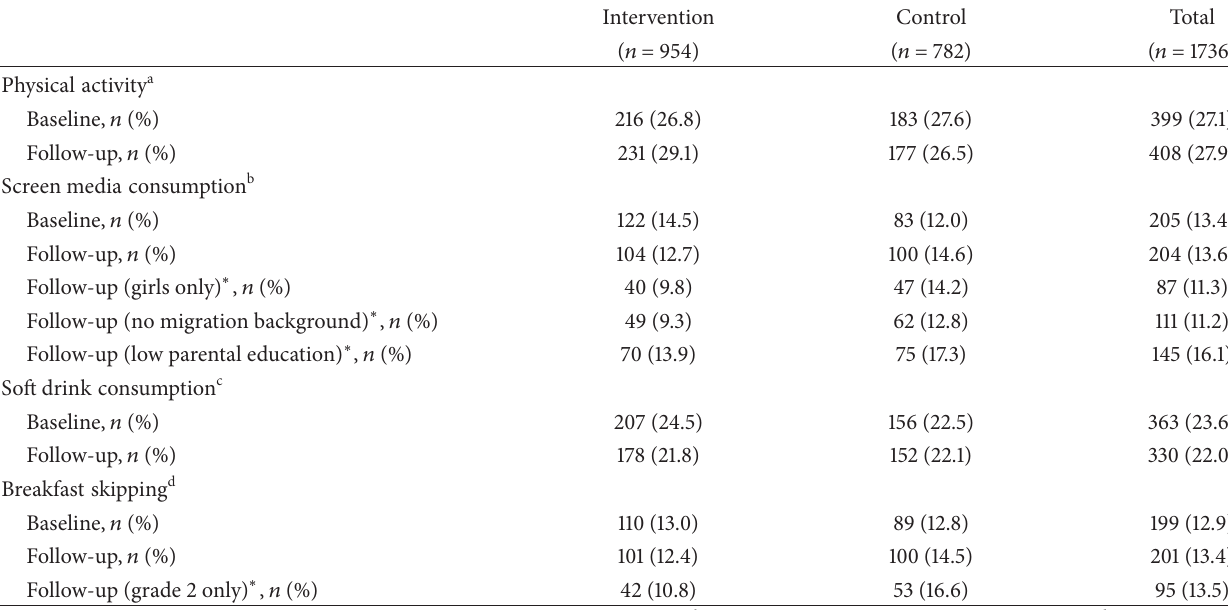
Table 2: Baseline and follow-up results for physical activity, screen media consumption, soft drink consumption, and breakfast skipping. Intervention